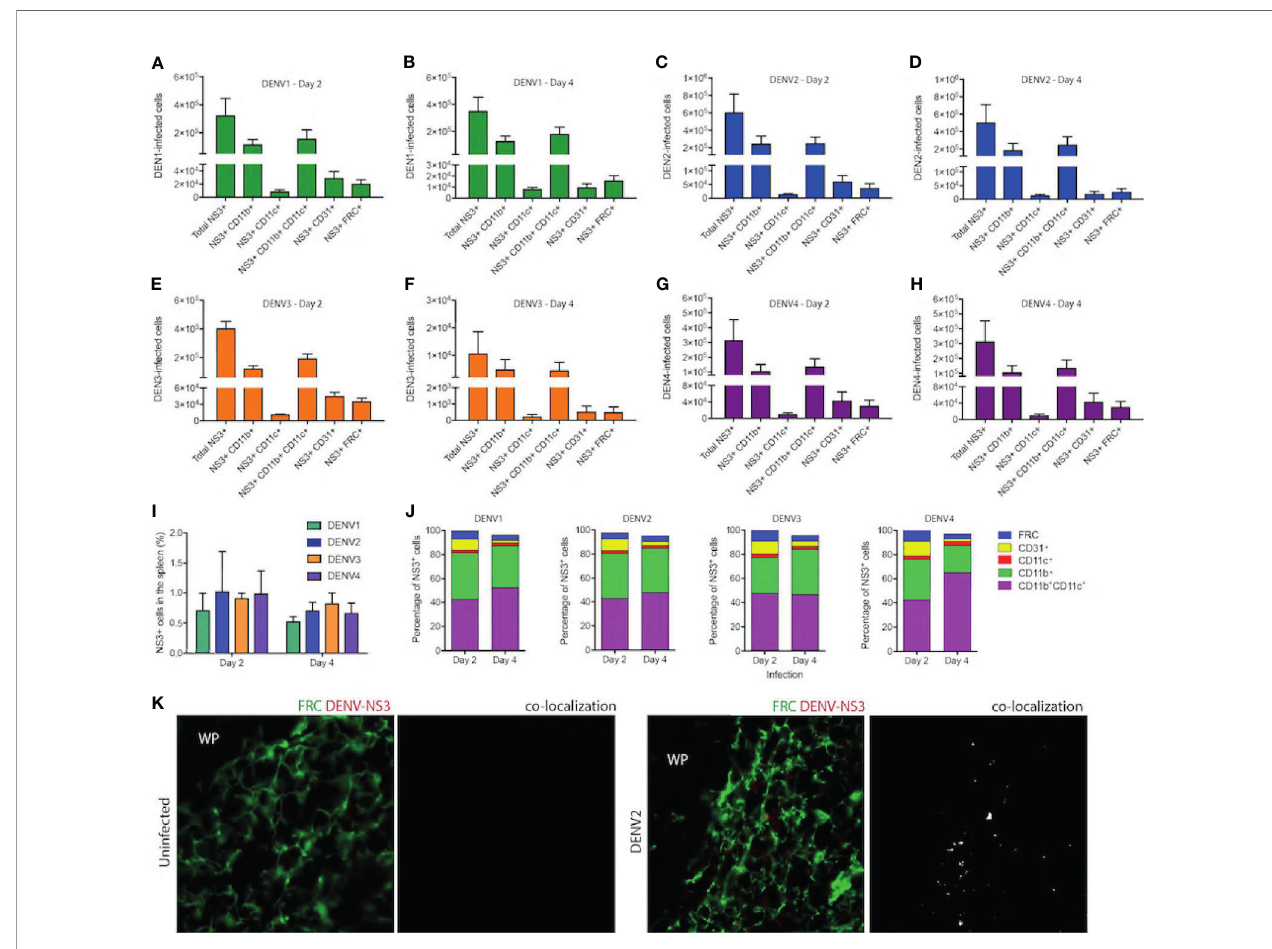
FIGURE 7 | Cells of myeloid lineage and FRCs are the targets of DENV infection in WT mice. Numbers of cells infected in the spleens of mice after injection with DENV1 on (A) Day 2 (B) Day 4, DENV2 on (C) Day 2 and (D) Day 4, DENV3 on (E) Day 2 and (F) Day 4, and DENV4 on (G) Day 2 and (H) Day 4. (I) Percentages of total splenocytes that are NS3 + on Days 2 and 4 for each serotype. (J) Phenotypes of infected splenocytes as a percentage of NS3 + cells on days 2 and 4 post- infection. (K) Spleen sections stained for FRCs and DENV-NS3 protein for uninfected and DENV2-infected mice are presented. Co-localization of FRC and DENV- NS3 staining can be observed for DENV2-infected but not uninfected sections. White pulp location is indicated by